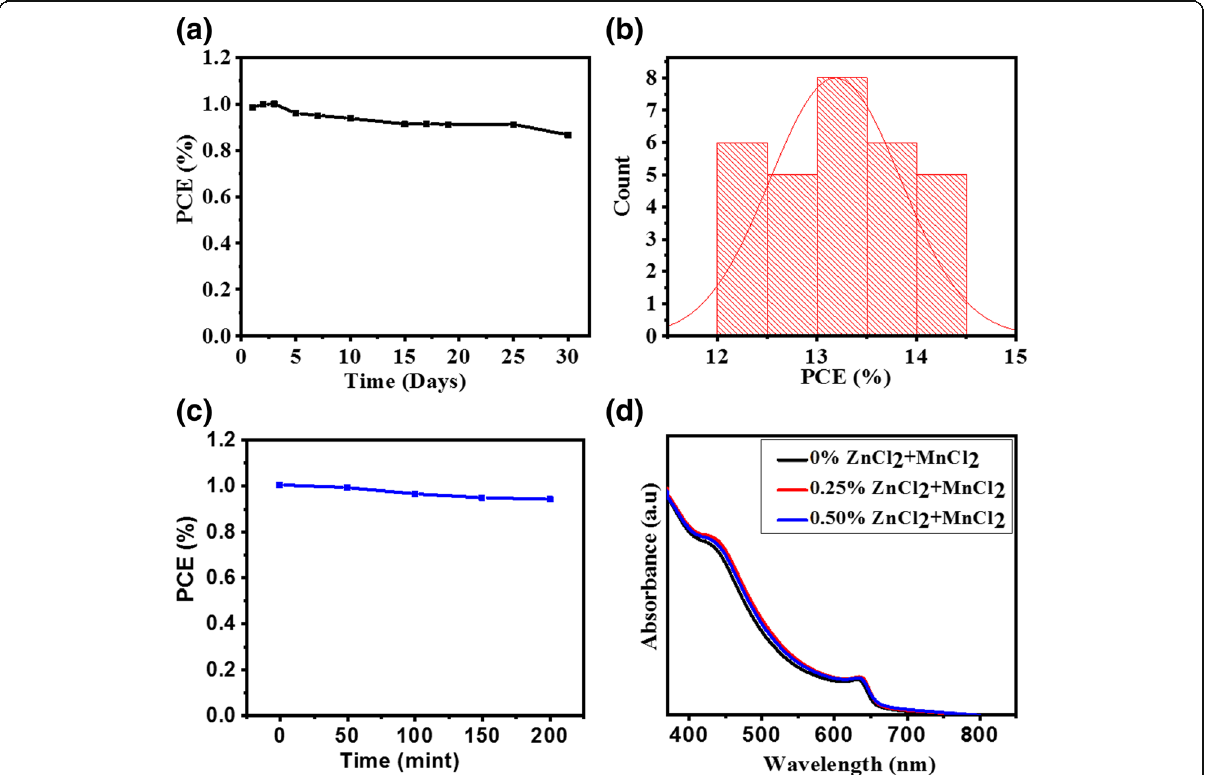
Fig. 4 Normalized V oc , J sc , FF, and PCE for the solar cell based on the CsPbI 2 Br-0.25% film as a function of storage time ( a ). Histogram of power conversion efficiency values for 30 devices ( b ). Normalized PCE for the solar cell based on the CsPbI 2 Br-0.25% film as a function of thermal treatment time ( c ). Absorption spectra ( d